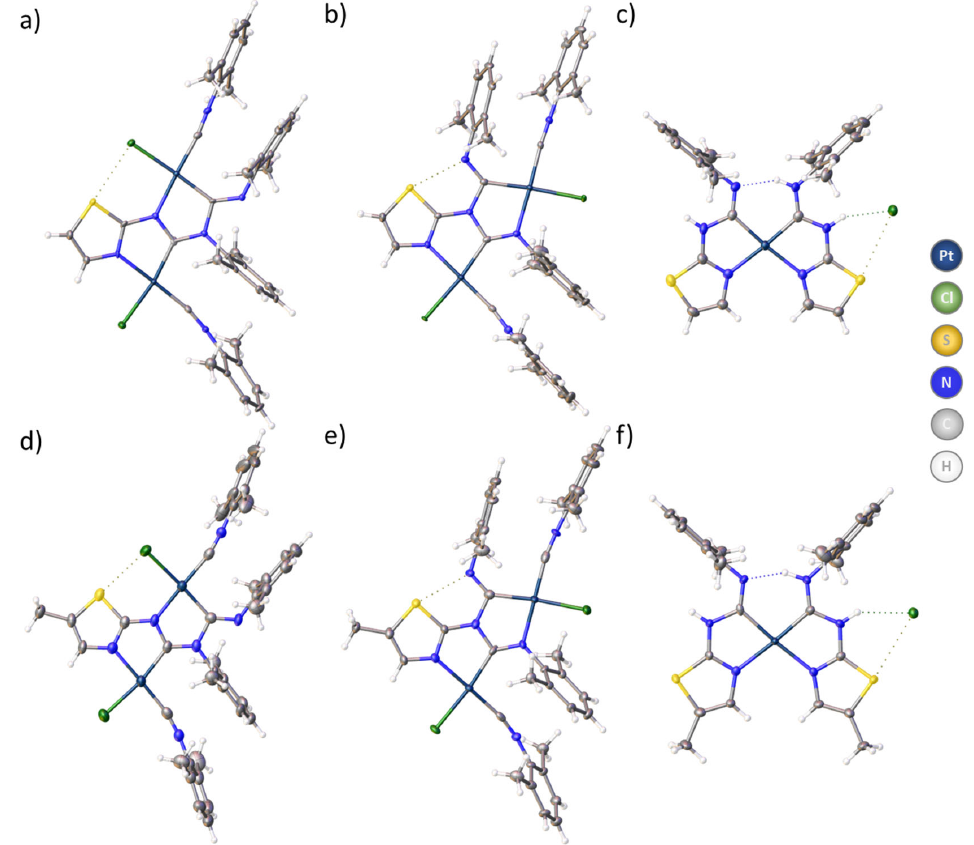
Figure 3. Views of crystal structures of complexes: 4a ( a ), 4b ( b ), 6 ( c ), 5a ( d ), 5b ( e ), 7 ( f ). Dotted lines indicate S ∙∙∙ Cl, S ∙∙∙ N, H ∙∙∙ Cl and H ∙∙∙ N noncovalent